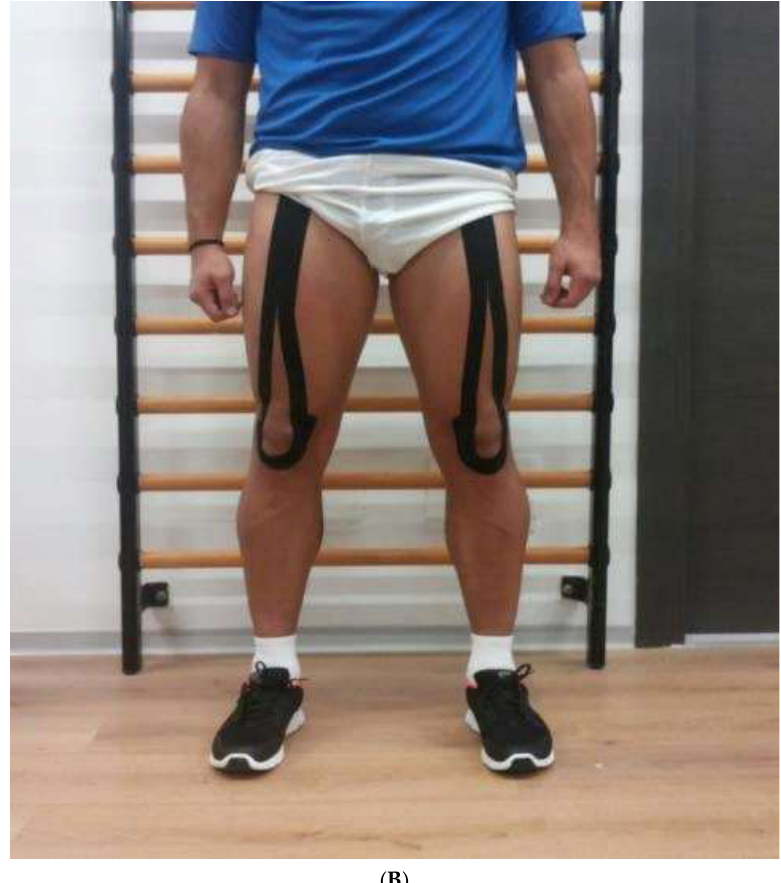
Figure 1. ( A ) Hamstring muscles tape application. ( B ) Quadriceps muscles tape